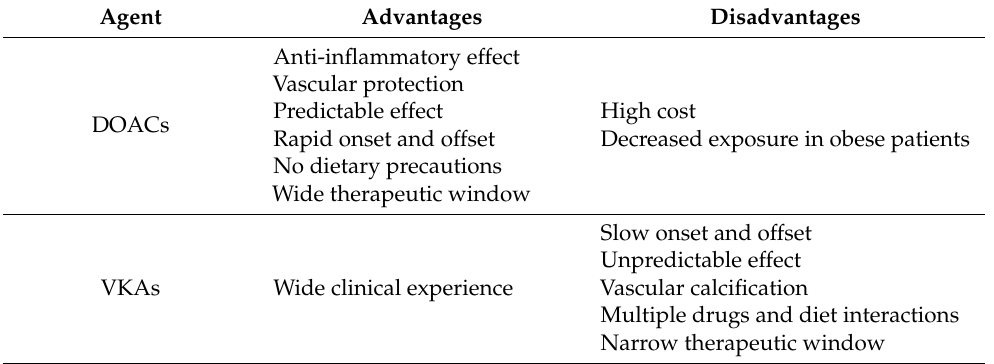
Table 1. Summary of DOAC advantages and disadvantages versus VKAs. DOAC—Direct Oral AntiCoagulants, VKAs—Vitamin K